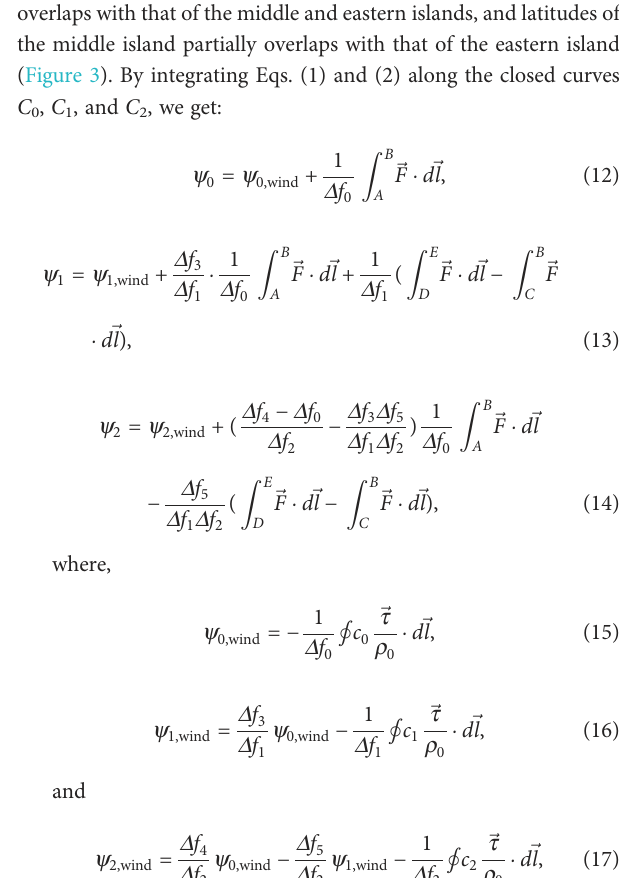
Case 2: In this case, latitudes of the western island partially overlaps with that of the middle and eastern islands, and latitudes of the middle island partially overlaps with that of the eastern island (Figure 3). By integrating Eqs. (1) and (2) along the closed curves C 0 , C 1 , and C 2 , we get: